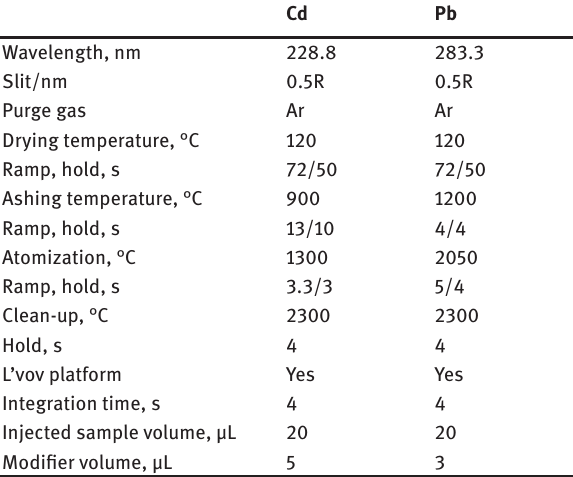
Table 1: Basic instrumental parameters of ETAAS for the determination of Cd and Pb in tea